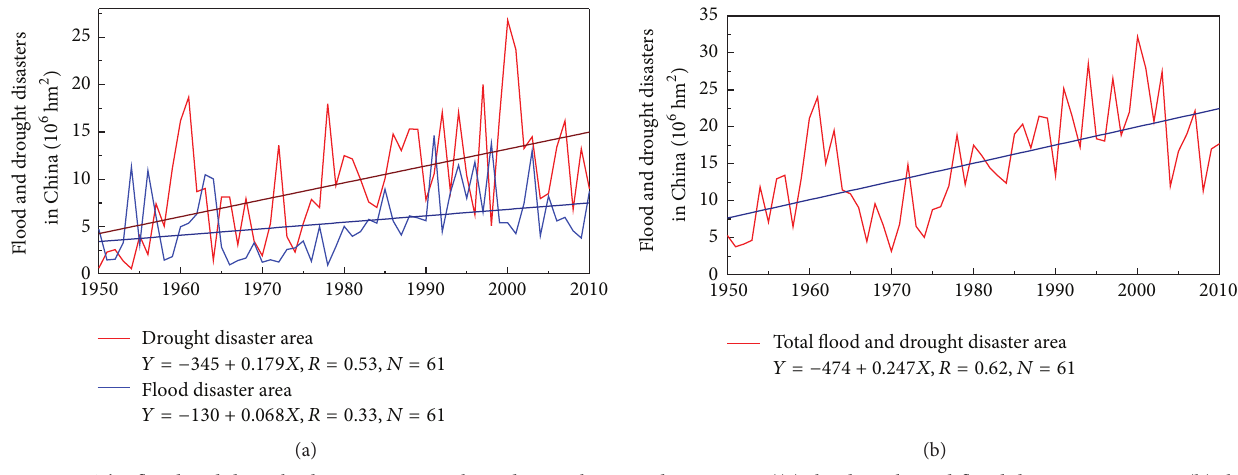
Figure 3: The flood and drought disaster area in China during the period 1950–2010 ((a) the drought and flood disaster area, resp.; (b) the total disaster area of drought and